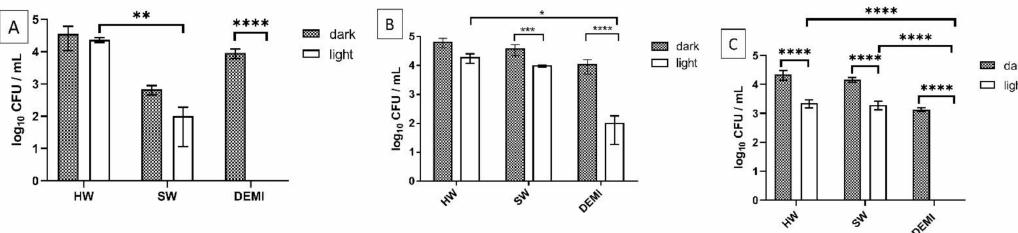
Figure 11. Impact of the PDI on L. pneumophila biofilm formation in different water samples (DEMI, SW, HW) by using TMPyP3 ( A ), TMPyP3-CH 3 ( B ), and TMPyP3-C 17 H 35 ( C ) in concentration 0.25 × MEC determined in SW (0.782 µ M for TMPyP3-CH 3 and TMPyP3-C 17 H 35 , 1.563 µ M for TMPyP3), after irradiation for 10 min with violet light (395 nm, total light dose 12 J/cm 2 ). The treatment with PSs without irradiation was used as a “dark” control. All data are presented as mean ± SD; **** p < 0.0001, *** 0.0001 < p < 0.001, ** 0.001 < p < 0.01, * 0.01 < p < 0.05.